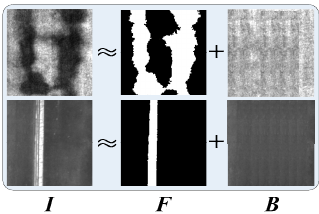
Figure 1. Illustration of surface defect image decomposition.